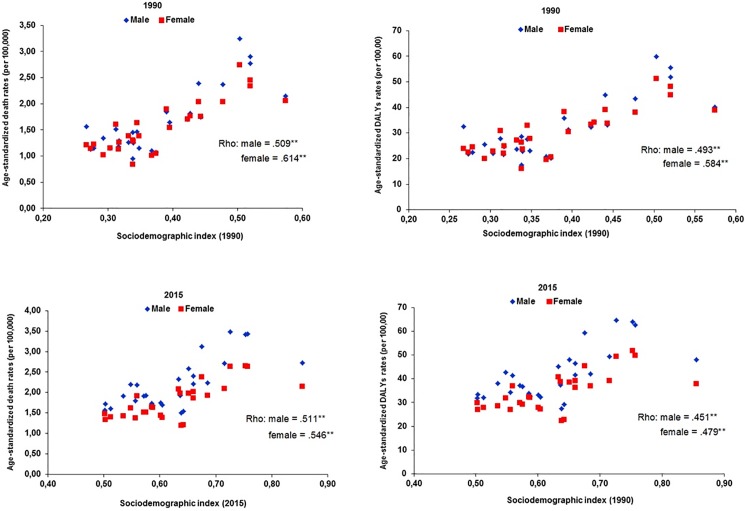
Relationship between age-standardized rate and DALYs from colorectal cancer due to physical inactivity and sociodemographic index of the Brazilian states in 1990 and 2015 according to sex.Rho: Spearman's correlation coefficient; ** p <0.01.